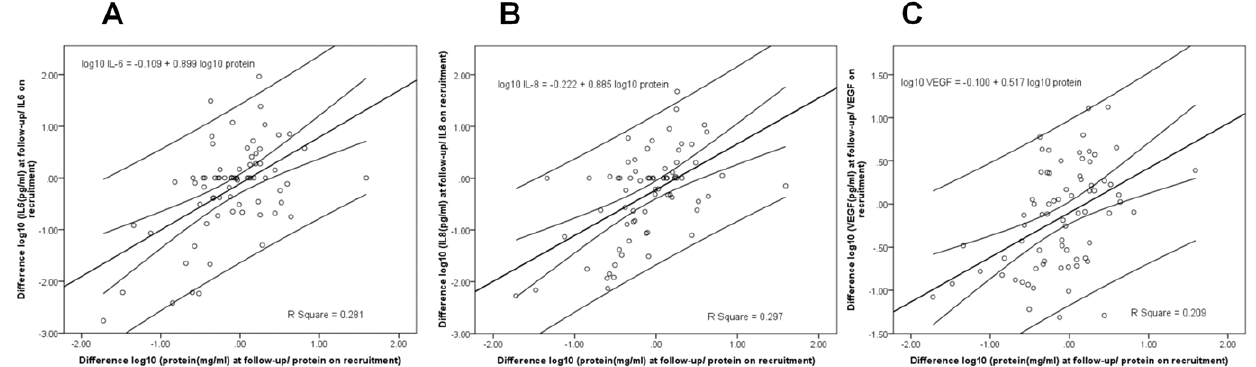
Figure 6. Regression analyses to determine the relationship between differences in standards and biomarkers over time. Scatter plots, based on data from 72 hematuric patients, plotting the differences between biomarker levels on recruitment and follow-up against the differences between protein levels on recruitment and follow-up for (A) IL-6, (B) IL-8 and (C) VEGF. The regression line and 95% confidence interval show significant associations (p , 0.0001 for all biomarkers). Differences in biomarker levels across time were associated with differences in protein levels.